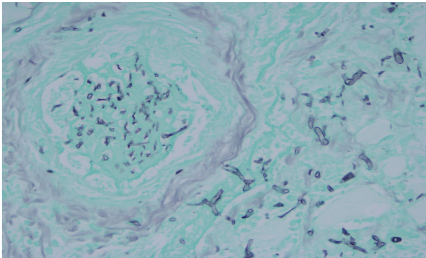
Figure 2: Image of thyroid at autopsy showing thrombus with hyphae in vessel (left) and invasive Aspergillus organisms in thyroid (right). Gomori Methenamine Silver stain, 60x